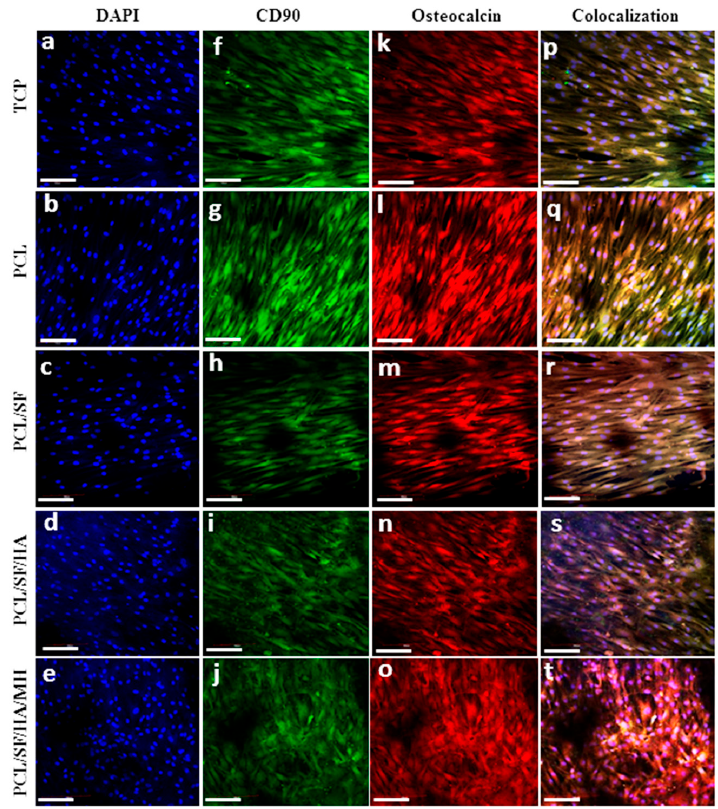
Figure 13. Confocal microscopy images to confirm the MSCs differentiation into osteogenesis. Nuclear staining DAPI ( a – e ) blue, MSCs specific marker protein CD90 ( f – j ) green, and osteoblasts specific marker protein osteocalcin ( k – o ) red. Merged images showing the dual expression of both CD90 and osteocalcin, characteristic of MSCs cells which have undergone osteogenic differentiation ( p – t ) on TCP ( a , f , k , p ), PCL ( b , g , l , q ), PCL/SF ( c , h , m , r ), PCL/SF/HA ( d , i , n , s ) and PCL/SF/HA/MH ( e , j , o , t ) with the nuclear staining by DAPI ( a – e ) at 20× magnification (Scale bar: 50 µm).